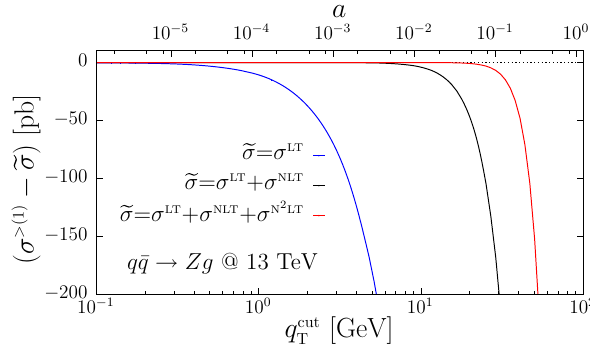
(cid:9) (cid:10) σ >( 1 ) − ! σ ! σ = σ LT + σ NLT aredisplayedinblackandfor ! σ = σ LT + σ NLT + σ N 2 LT as a function are displayed in red. The corresponding values of a = displayedonthetopofthefigure. Thestatisticalerrorsoftheintegration are also shown, but they are totally negligible on the scale of the figure